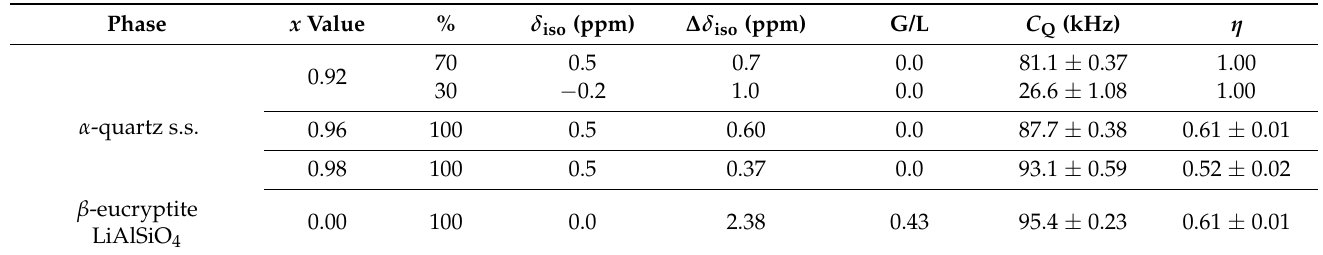
Figure 2. Linear variation of the temperatures T h and T c of the α → β transition of quartz on heating and cooling with the stoichiometric substitution of Si by Al + Li, with an x value in Li 1 − x Al 1 − x Si ≥ 0.96. The 7 Li MAS NMR spectra for x = 0.92 and x = 0.96, using 1+x O 4 , using three points for x samples crystallized at 900 ◦ C and 3 kbars, are shown. Table 3. Deconvolution of the 7 Li MAS NMR spectra of hydrothermal α -quartz and fully ordered β